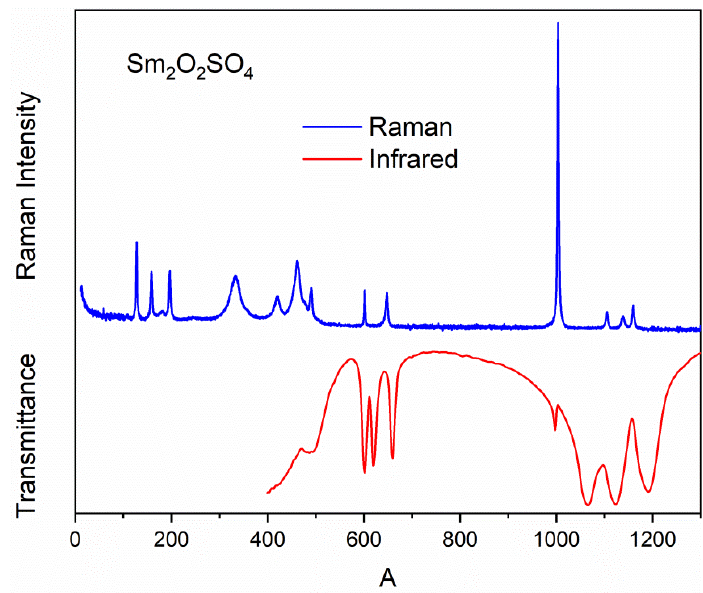
Figure 8. Raman and Infrared spectra of Sm 2 O 2 SO 4 powder. Table 4. Correlation diagram of internal vibrations of the [SO 4 ] 2 − ions in the Sm 2 O 2 SO 4. Wavenumber (cm −1 ) [51]